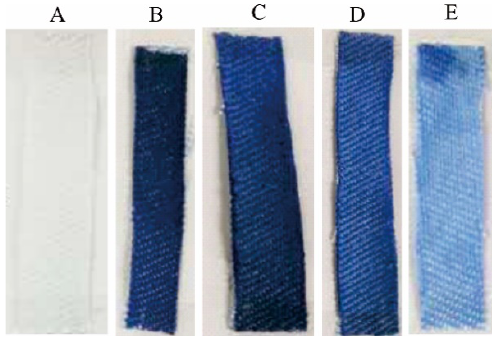
Figure 5. Qualitative test results of PHMB-coated fabric samples dyed with BPB: ( A ) pristine uncoated fabric; ( B ) no wash; ( C ) 26 washing cycles; ( D ) 52 washing cycles; and ( E ) 104 washing cycles.